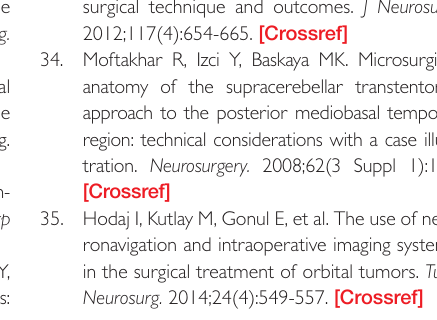
giomas: surgical technique, microsurgical anat- omy, and case illustrations. Neurosurg